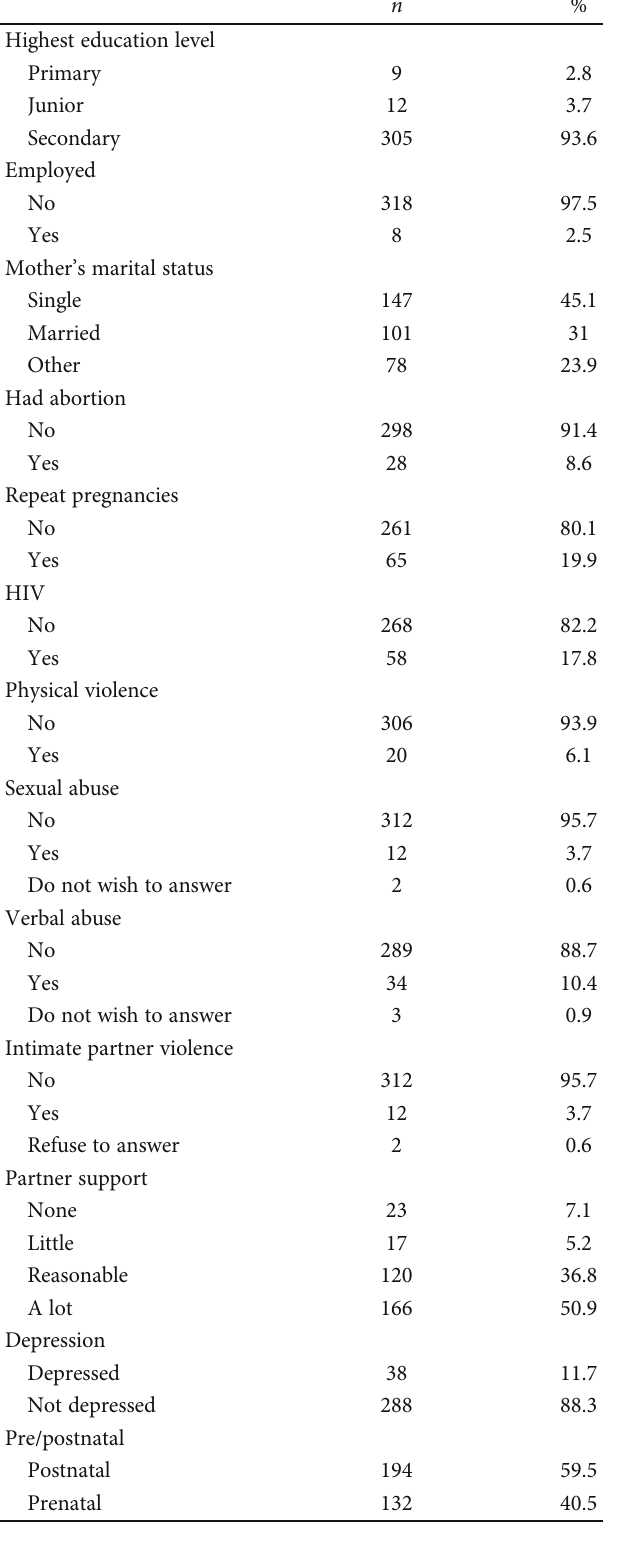
Table 2: Frequency distributions for key categorical variables in this analysis ( n = 326 ).